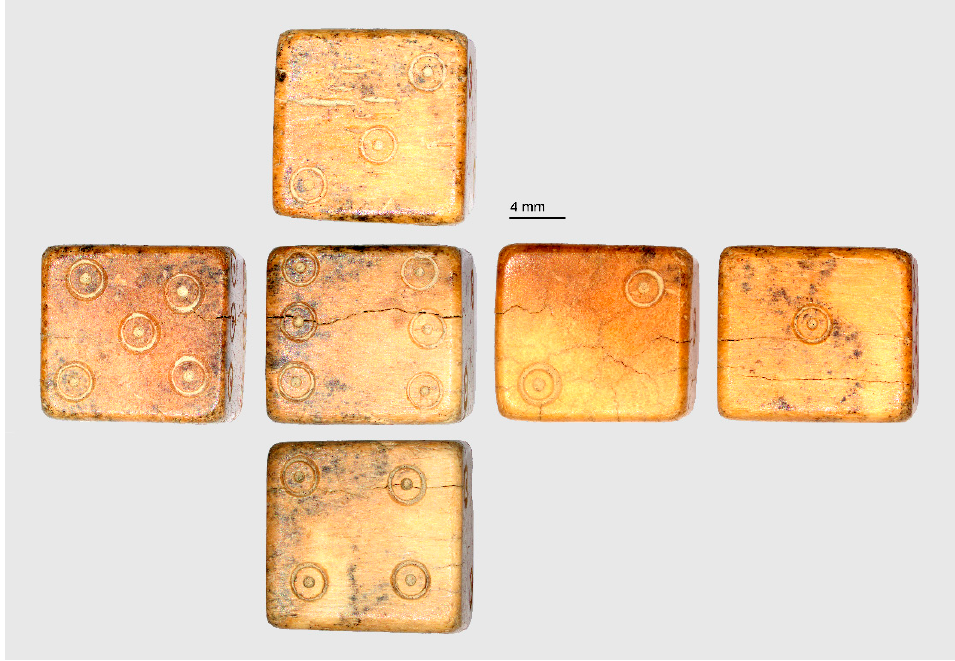
Figure 6. The dice SP909 from Villa del Foro, with numbers 1–6 incised in the “7 rule” configuration. Scale bar: 4 mm.